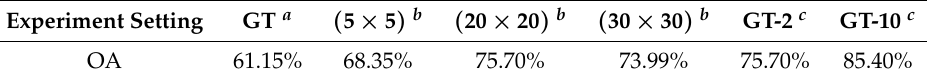
Table 3. The third experiment results. Evaluation of pretraining on Pigments dataset using the proposed approach and classes created from ground truth. The objective was to collate the performance of artificial labels of different sizes with those created through splitting or joining the ground